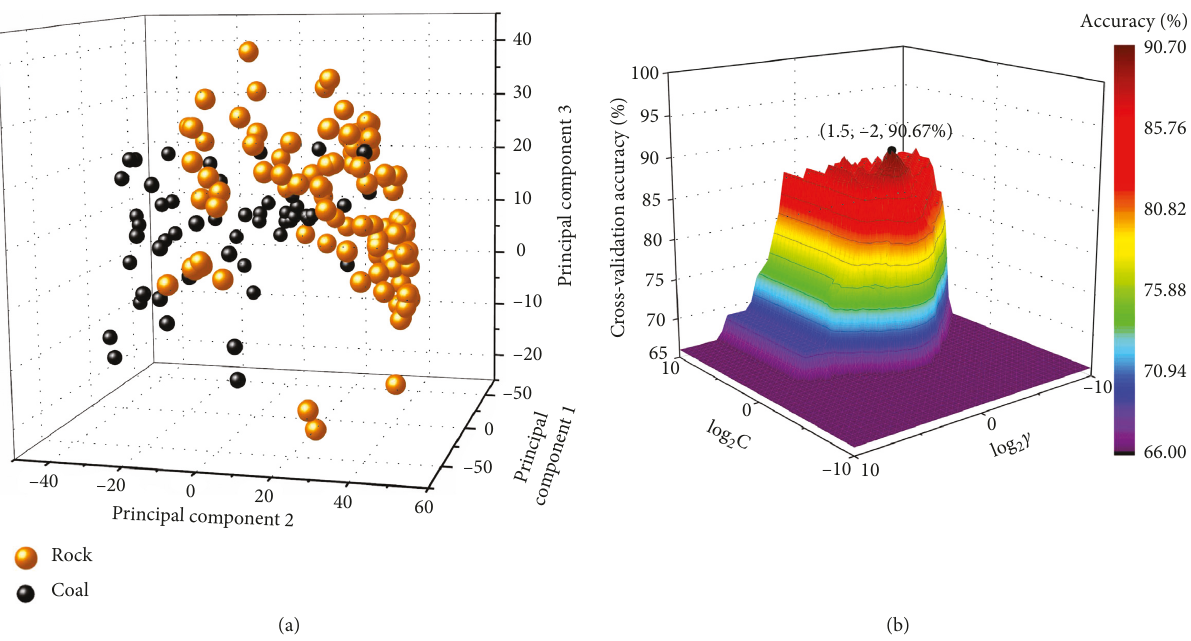
Figure 8: (a) 3D spatial distribution of the first three PCs of CR spectra of the 150 training samples in the eight selected regions in Table 1 through PCA; (b) process of searching for the optimal penalty parameter c and the radial basis function variance parameter c of PCA-SVM model through cross validation with the first ten PCs as input